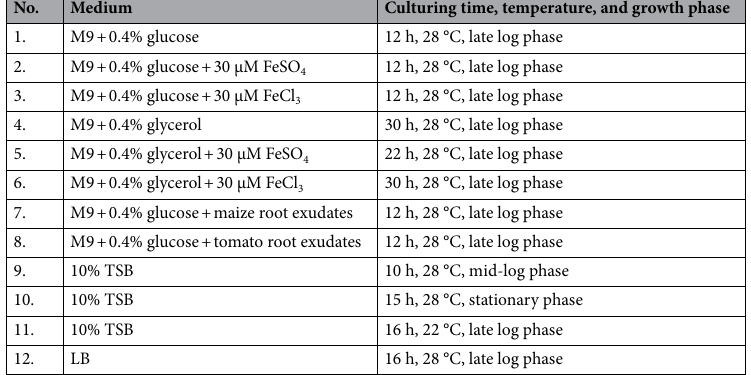
The antibacterial activity of the KN4243 mutant showed about 40% of the P482 wt strain activity against both pathogens when glucose was the sole carbon source and even lower (ca. 30%) activity when glycerol was used. This suggests that the efflux pump transport protein (encoded in locus BV82_4243) might facilitate the antibacterial activity of P482 wt. These results suggest that carbon source largely affects the part of P482 antimicrobial activity determined by the genes of the “cluster 17”. The total loss of this activity in KN4240 in glycerol points to this operon as the main determinant of the antimicrobial activity of P482 under this condition. The gene in locus BV82_4243 is also associated with P482 antagonism towards plant pathogens, possibly by encoding an efflux pump transporting the antibacterial compound outside the cell, however, the antimicrobial activity of the KN4243 mutant is not particularly influenced by carbon sources investigated in this study. Selection of potential reference genes (RGs) for RT‑qPCR. The potential reference targets for P. coding for proteins from different functional groups . Ten candidate genes, namely: acpP , algD , gyrB , lexA , mrdA , proC , recA , rpoB , rpoD and tuf were selected for the analysis of their expression stability (loci and annotation